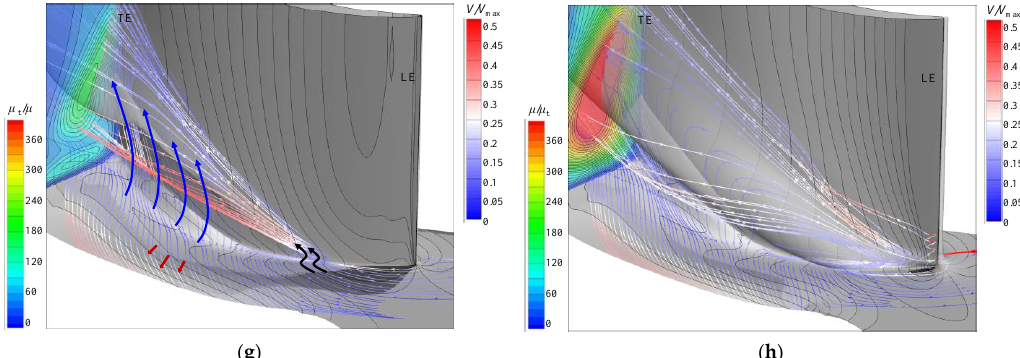
Figure 11. The three-dimensional flow field of the baseline and end wall contouring cases: ( a ) i = − 1°, baseline; ( b ) i = 7°, baseline; ( c ) i = − 1°, case c1; ( d ) i = − 1°, case c1; ( e ) i = − 1°, case c2; ( f ) i = − 1°, case c2; ( g ) i = − 1°, case c3; ( h ) i = − 1°, case c3. At the design point (Figure 11a,c,e,g), the transparent grey area in the figures is the iso-surface of V z = 0.1 V max , which indicates the development of separation in the corner region. The contours show the normalized turbulent viscosity ( µ t / µ ) within the TE plane, representing the local shear loss caused by separation. The colored curves in the figure are the three-dimensional streamlines in the end wall region, and the color indicates its velocity magnitude. The iso-curve of the static pressure coefficient ( p ) is plotted on the end wall and blade surface. p is defined